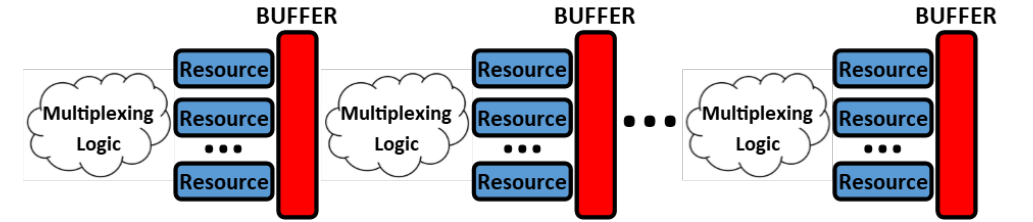
Figure 7. Proposed resource implementation scheme.